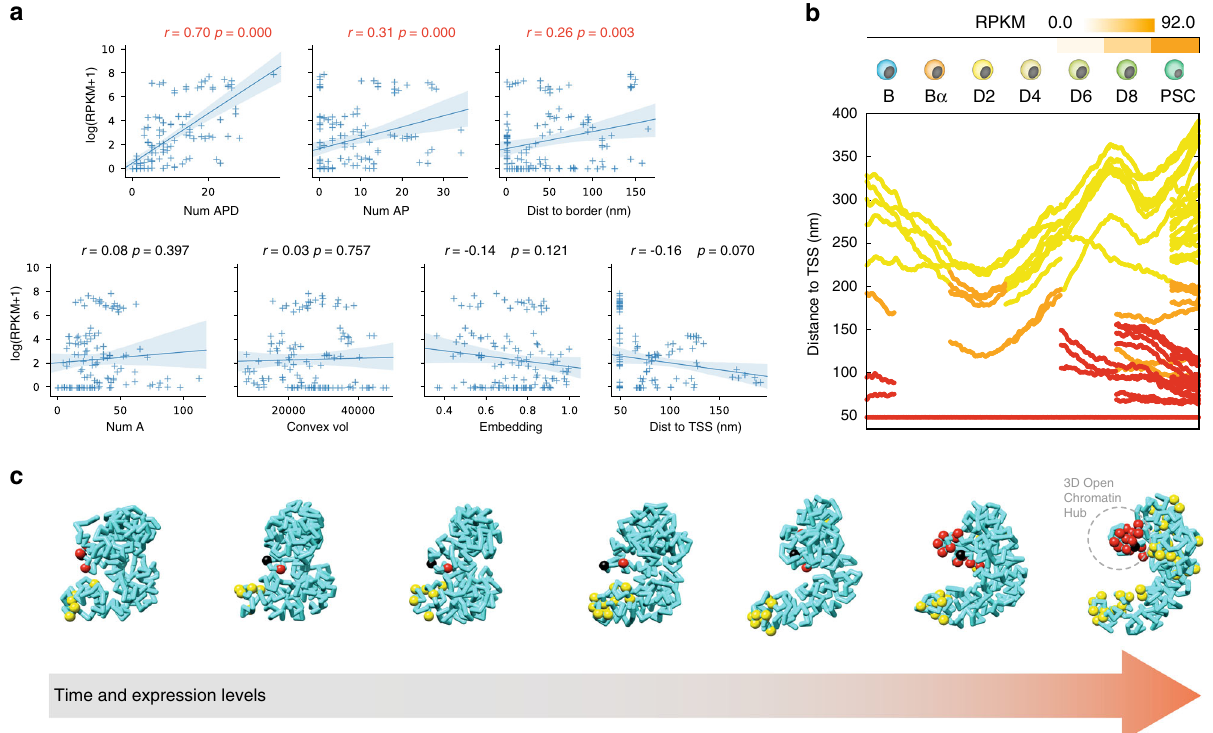
Fig. 5 The formation of 3D hubs of active chromatin triggers dynamic gene activation. a Correlations between structural features of the models and expression of the resident genes. Each of the seven panels show the scatter-plot, the linear regression model fi t line, and the 95% con fi dence interval between expression (log(RPKM + 1)) with respect number of APD particles, number of AP particles, TSS distance to the closer border, number of A particles, explored (convex-hull) volume, structural embedding and TSS-TTS distance, respectively. The linear regression r coef fi cient and p-values, that are shown on top of each scatterplot, have been computed using Python (RegPlot function of the seaborn package). b Dynamic changes of the distance to the Sox2 locus TSS for each APD (red), AP (orange) and A (yellow) particles during reprogramming simulation. c Snapshots of the dynamic simulation of the Sox2 locus simulation with the chromatin represented as a cyan ribbon with the Sox2 locus TSS as a black sphere and all APD, AP and A particles as red, orange, and yellow spheres,